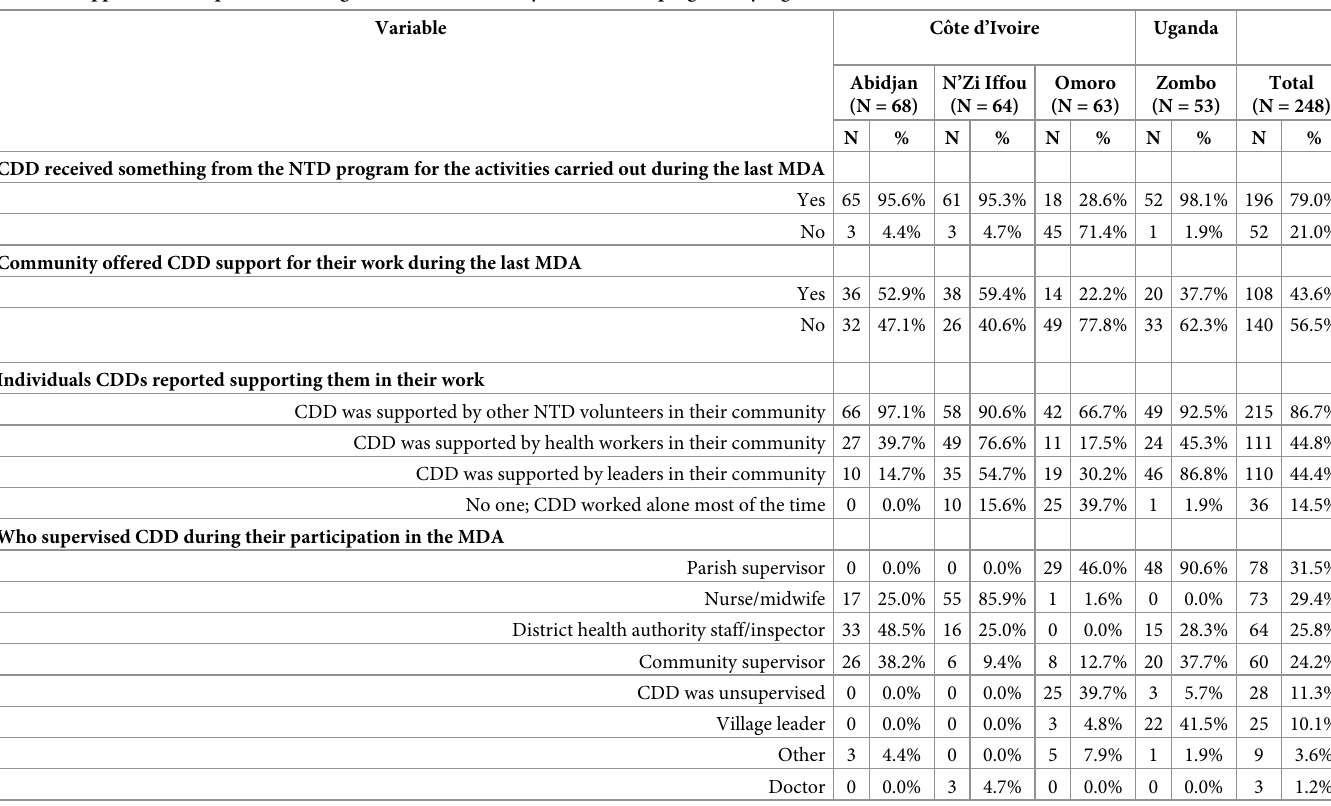
Table 8. Support CDDs reported receiving from their community and the NTD program, by region/district. Variable